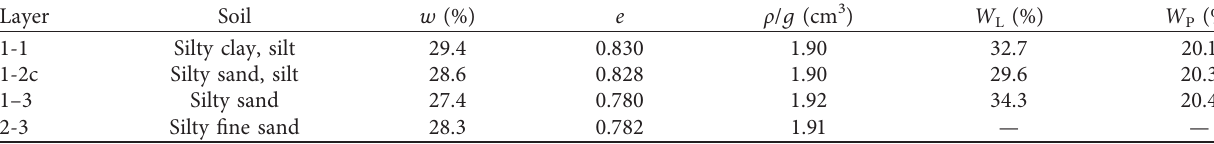
Table 1: Physical parameters of the sample soil layers.